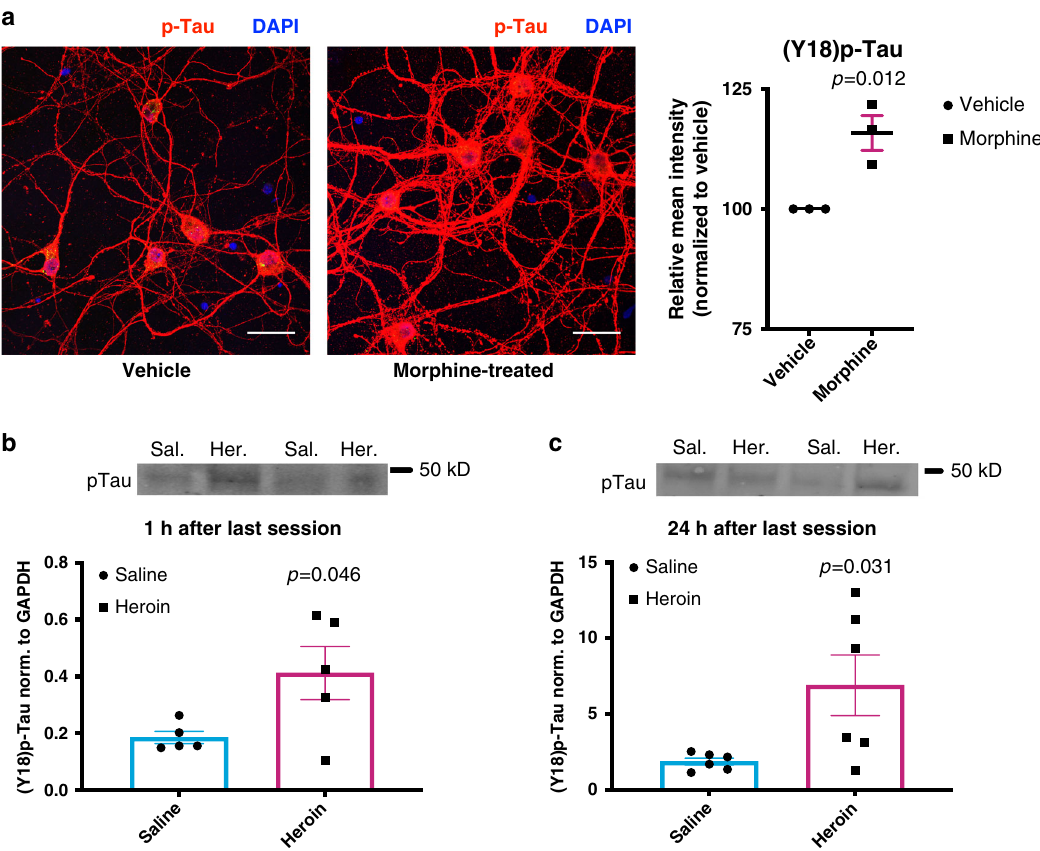
Fig. 5 Heroin leads to FYN-mediated hyperphosphorylation of Tau protein. a Immunocytochemistry analysis of vehicle and morphine-treated primary cortical-striatal co-cultured neurons revealed increased phosphorylation of Tyrosine-18 of Tau in morphine-treated cells ( n = 3 biological replicates/group, Student ’ s t -test, t 4 = 4.374, p = 0.0119). ×40 magni fi cation, scale bars represent 33 µ m. b , c Western blots from the caudate-putamen of heroin self- administering rats showed Tau hyperphosphorylation in vivo both 1 h (B; n = 5/group, Student ’ s t -test, t 8 = 2.359, p = 0.0461) and 24 h ( c ; n = 6/group, Student ’ s t -test, t 10 = 2.503, p = 0.0313) following the last self-administration session. Data are represented as mean ± SEM. DAPI 4,6-diamidino-2- phenylindole. Source data are provided as a Source Data fi